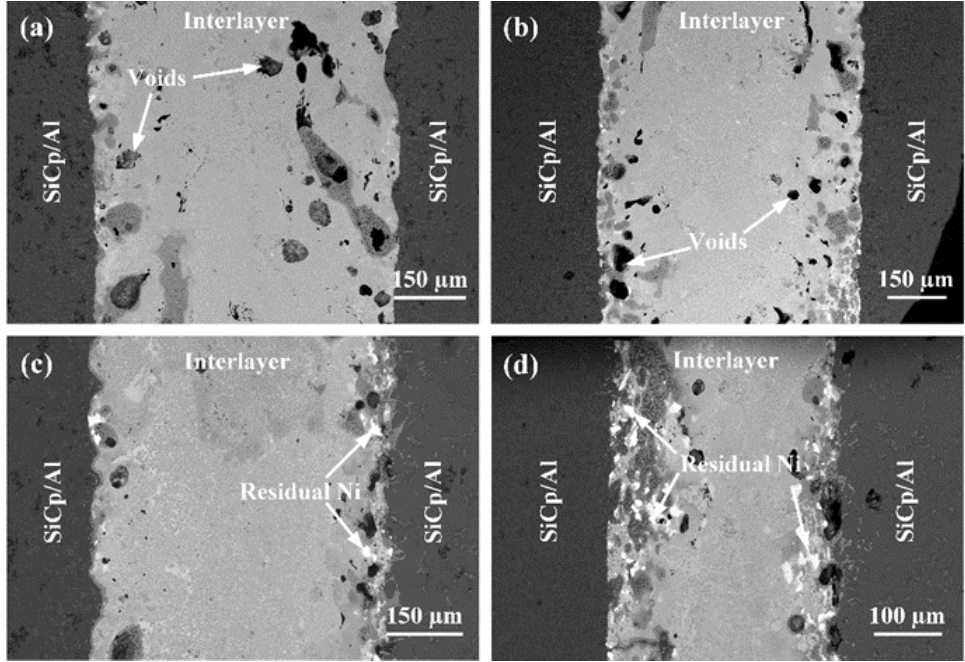
Figure 8. Microstructures of the joints bonded with different interlayers. ( a ) Zr 5 wt.%; ( b ) 8 wt.%; ( c ) 15 wt.%; ( d ) 20 wt.%.